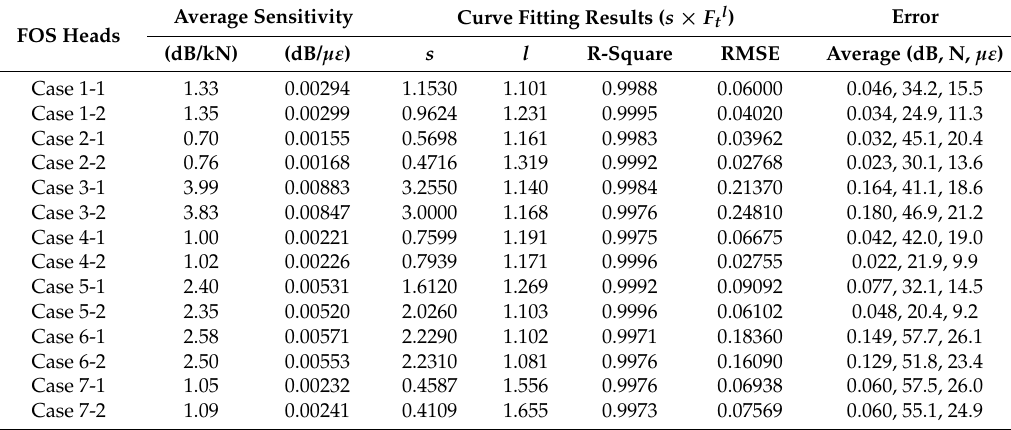
Table 2. Measurement results of tensile strain test.